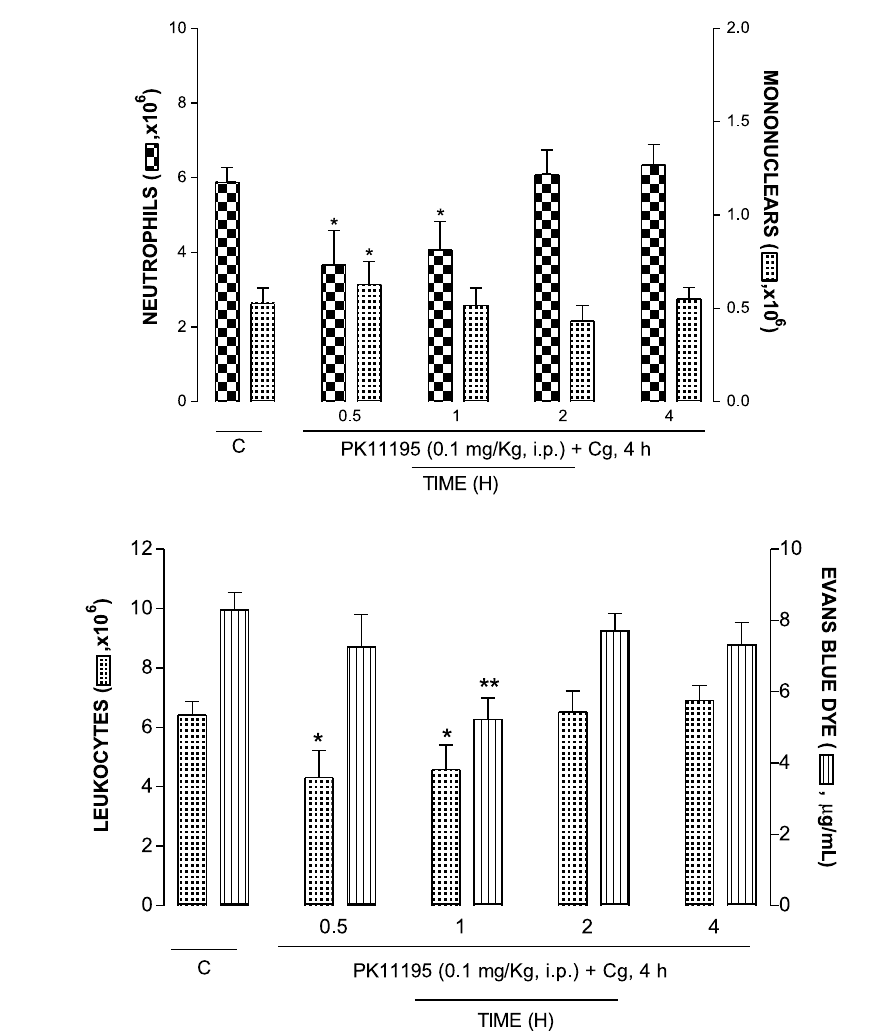
FIG. 1. Effects of PK11195 administered 0.5 (cid:1) / 4 h before carrageenan (Cg, 1%/cav.) on the early (4 h) phase of the mouse pleurisy induced by Cg. Leukocytes and exudation levels. Inset: Mononuclear and neutrophil cells, under the same conditions. C, Control responses in animals only treated with Cg. Each column represents the mean of four to six animals, and the vertical bars represent the standard error of the mean. * p B / 0.05 and ** p B /